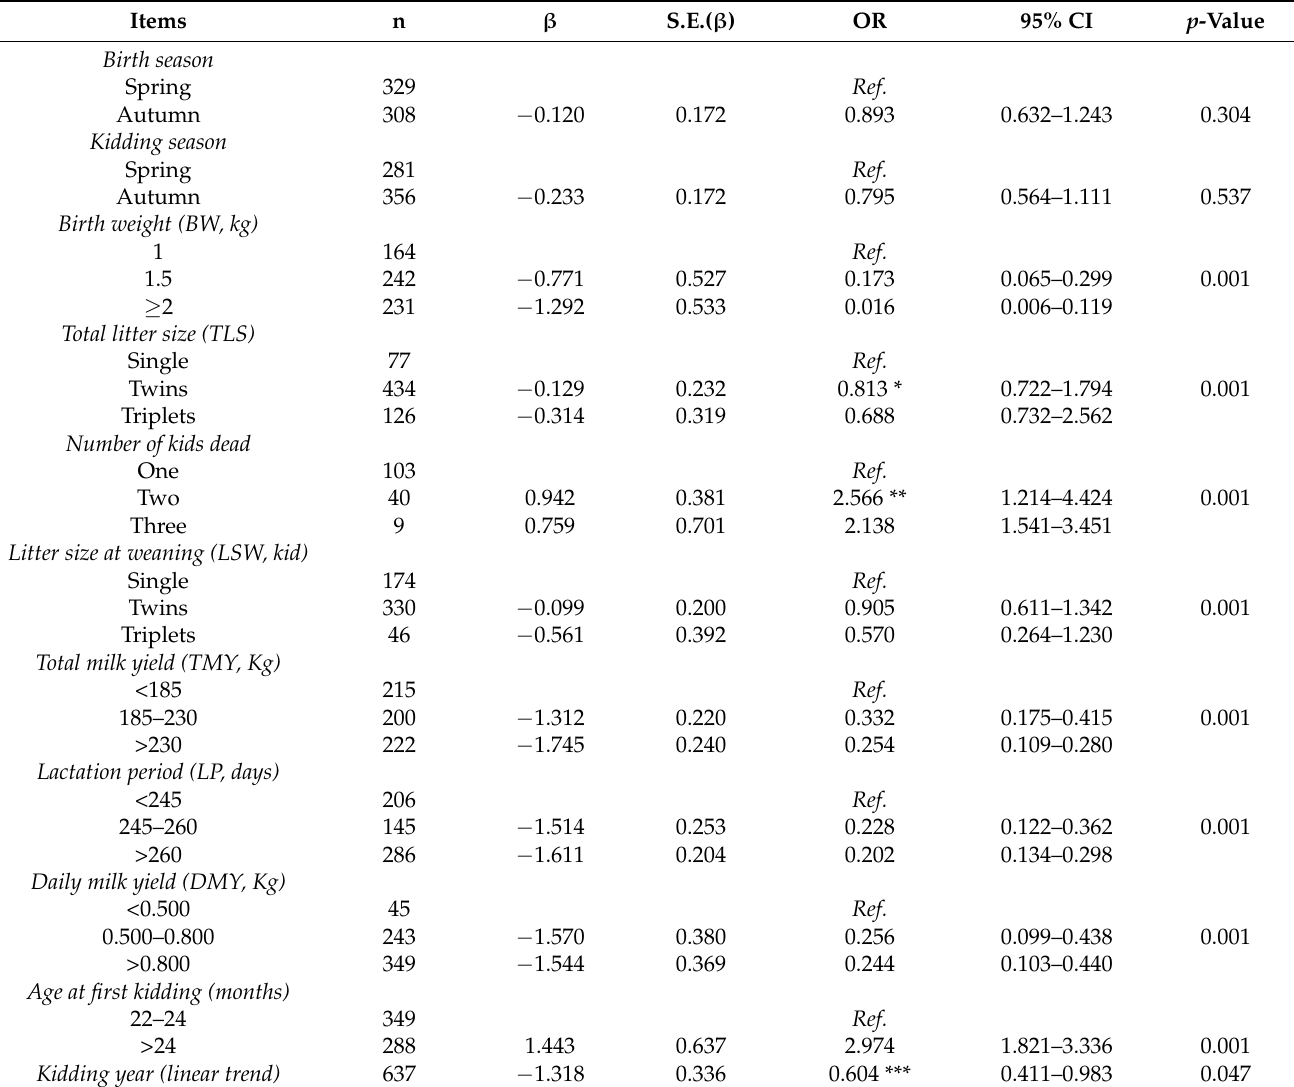
Table 3. Logistic regression analysis of different factors associated with the probability of being culled after first parity in primiparous dairy Zaraibi